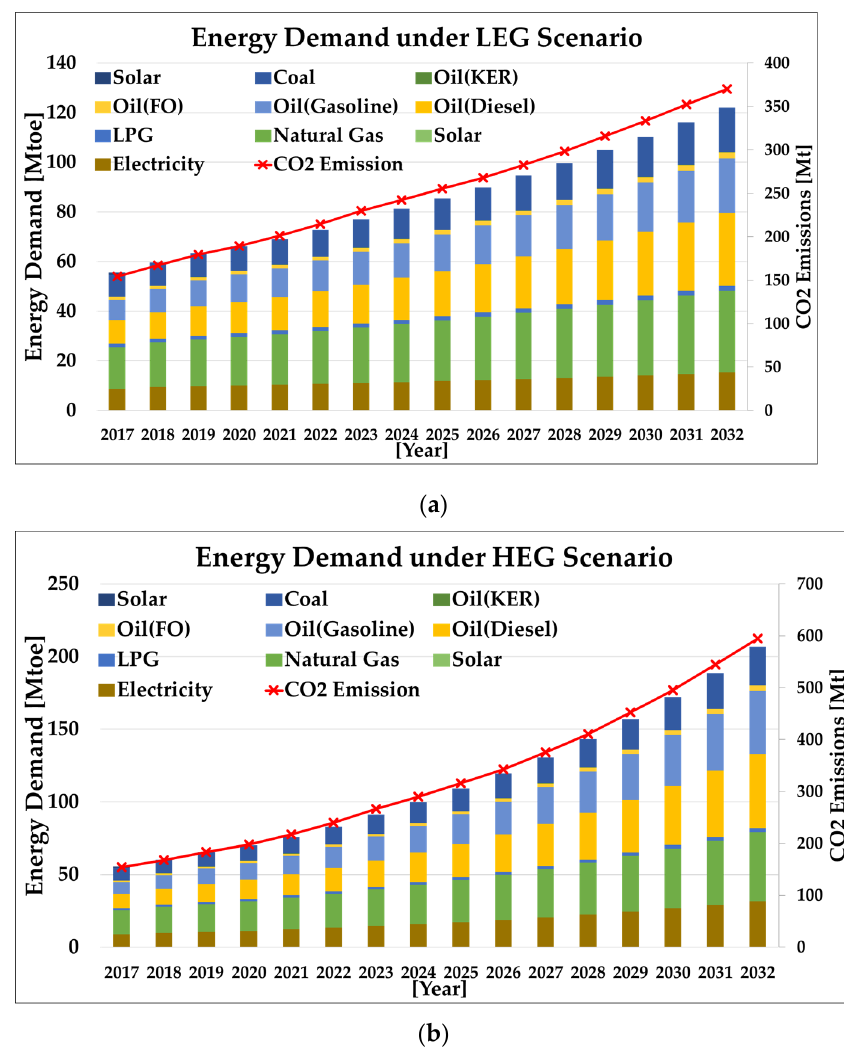
Figure 11. Energy demand and emission under ( a ) LEG and ( b ) HEG